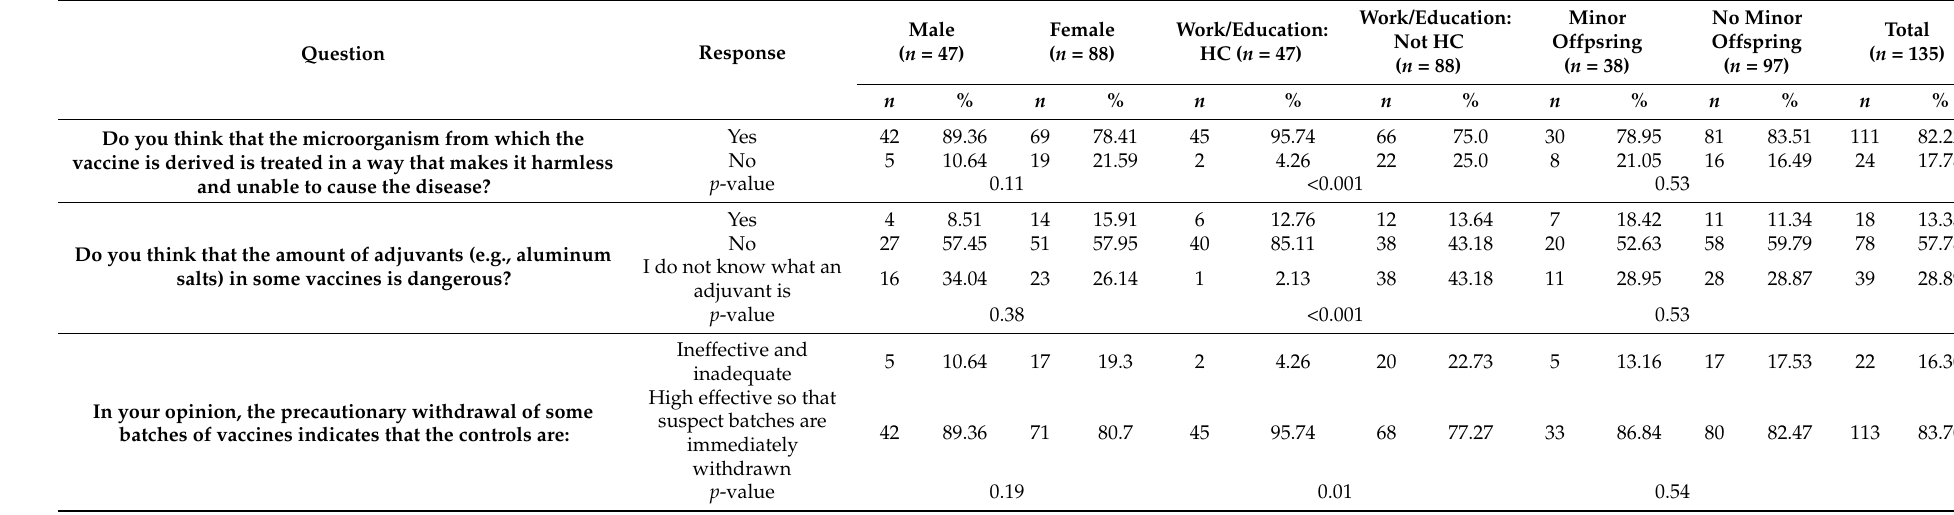
Table 3. Results of Section 3 of questionnaire: summary of the distribution of perceptions about vaccine components stratified by sociodemographic characteristics. (Note—HC: